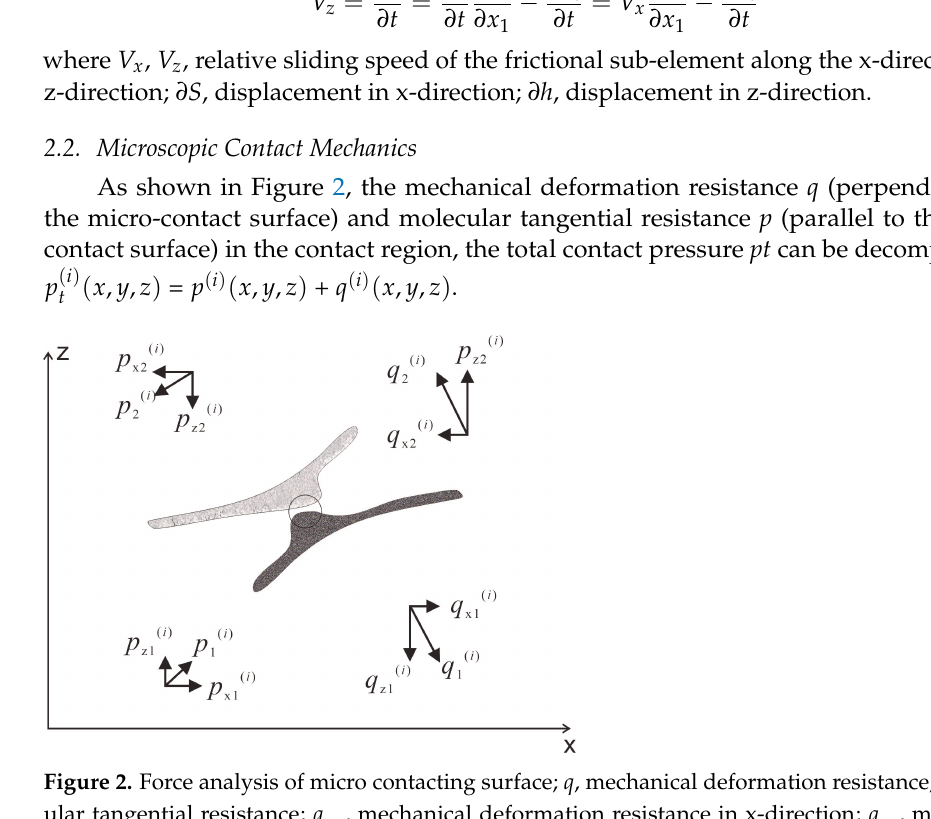
, mechanical deformation resistance in x-direction; q xn , molecular tangential resistance in x-direction; p xn